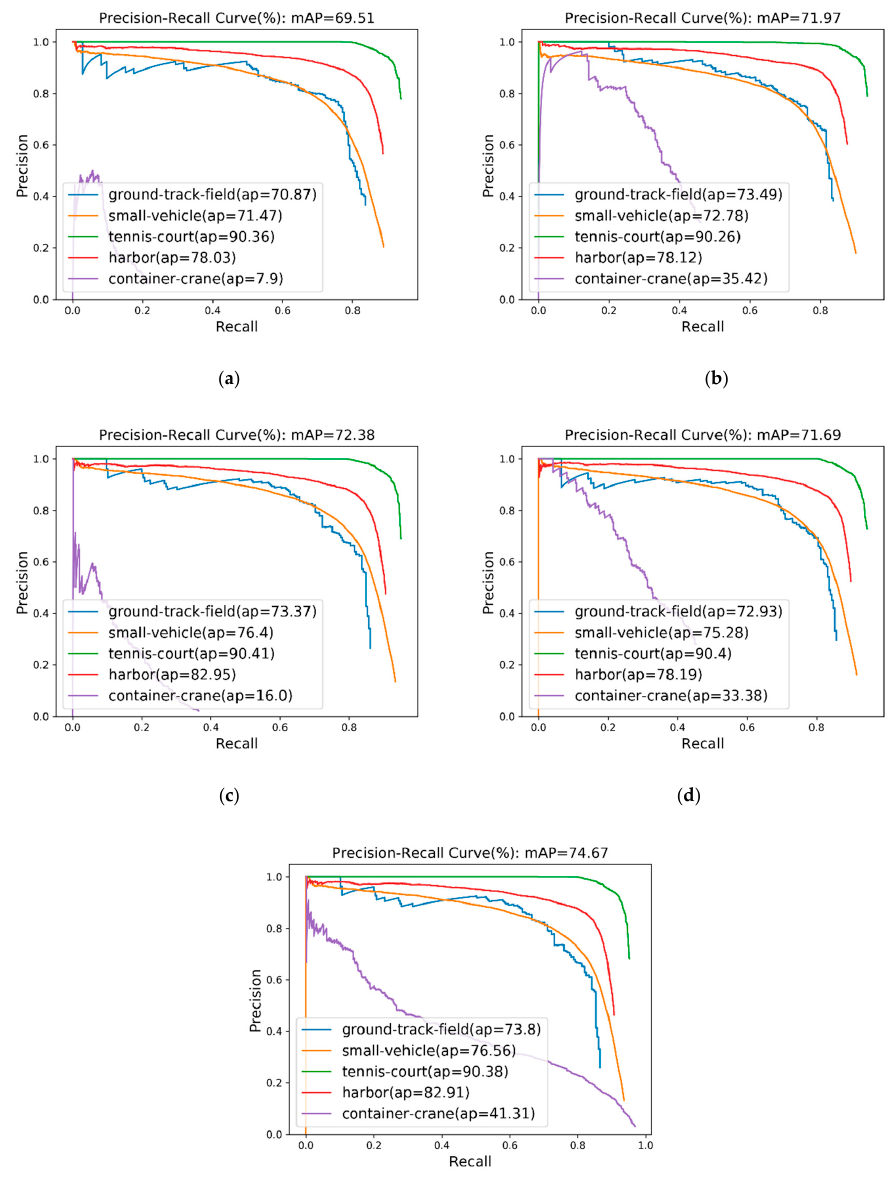
Figure 6. The precision-recall curves of Table 2: ( a ) FPN: Feature Pyramid Network. ( b ) FPN + MBDB: FPN with the multi-branched dilated bottleneck module. ( c ) FPN + AP: FPN with the attention pathway. ( d ) FPN + ABUP: FPN with the augmented bottom-up pathway. ( e ) EFPN: Extended Feature Pyramid Network.